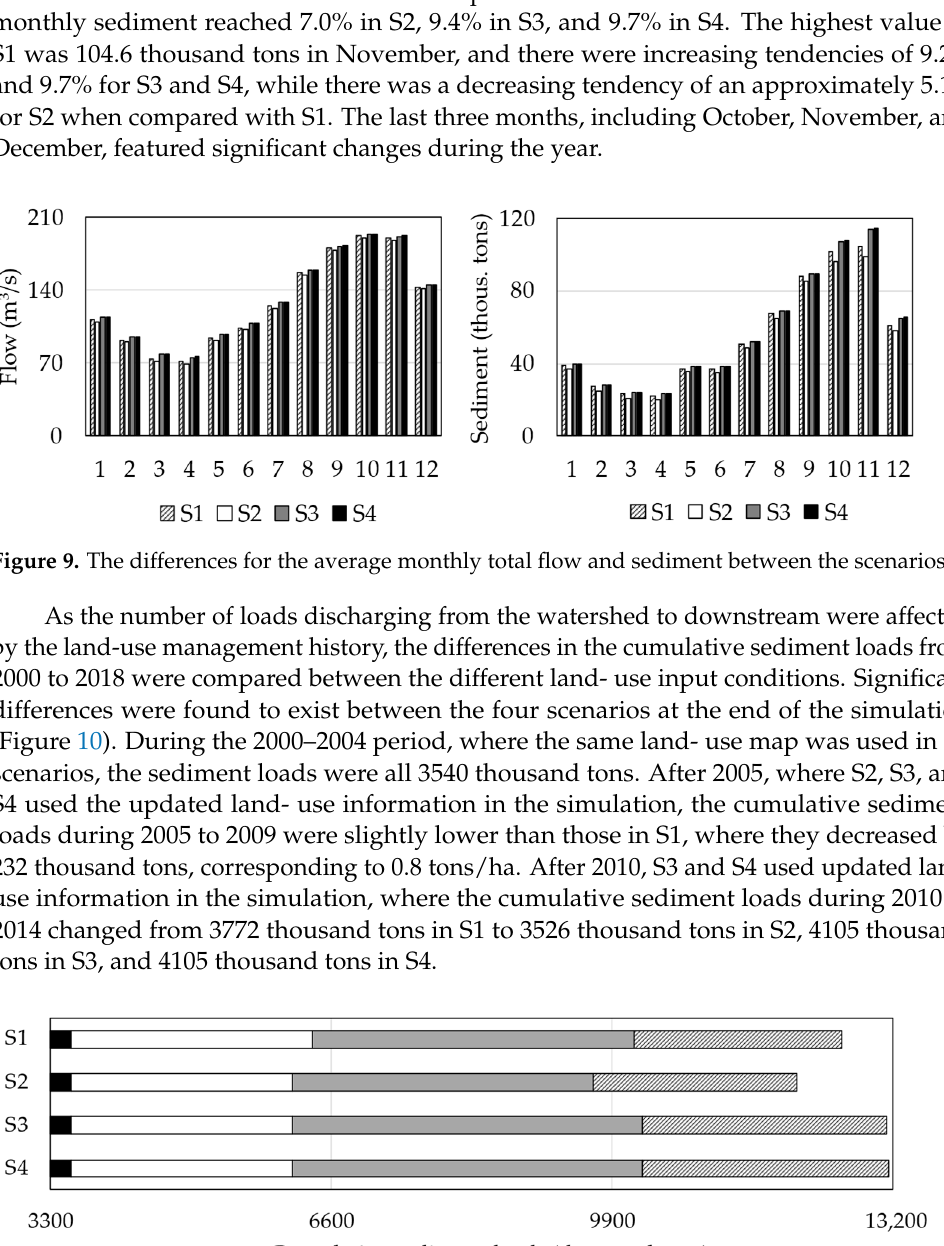
Figure 10. The change of cumulative sediment discharge between the scenarios from 2000 to